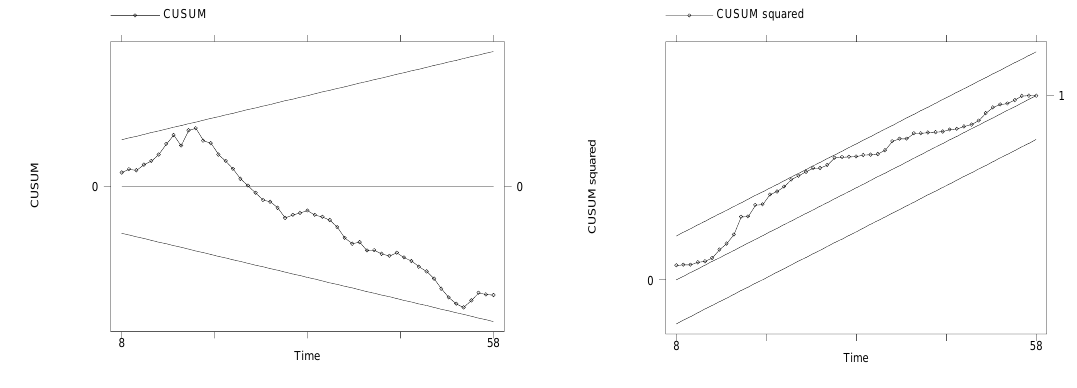
Figure 6. Stability tests (Model 1)